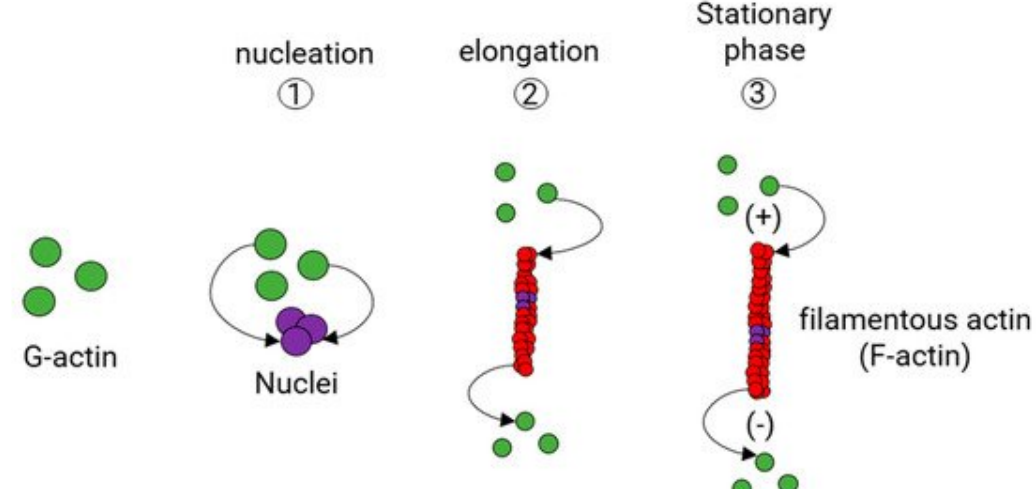
Figure 3. Actin treadmilling mechanism. Actin elongation and breakdown are contingent upon ATP levels; in f-actin elongation, g-monomers are “charged” (ATP rather than ADP + Pi) and are added to the positive (+) end. As it treadmills down towards the positive end, ATP is hydrolyzed to ADP + Pi, becomes unstable, and susceptible to cleavage proteins.